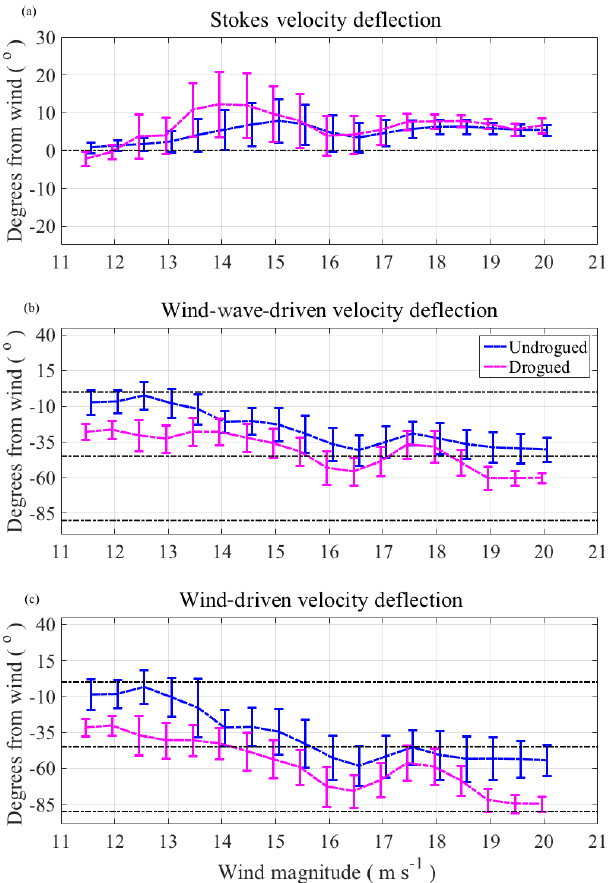
Figure 14. Average deflection angles at drifter locations during periods of high wind binned by UWIN-CM wind magnitudes on 0.5ms − 1 intervals. Horizontal dotted lines denote 0, 45 and 90 ◦ to the right of the wind. (a) UWIN-CM Stokes drift velocity di- rection at the surface (0m) and at 0.4m depth. (b) Velocity direc- tion of drogued and undrogued drifters after the subtraction of the pre-existing circulation estimate. (c) Velocity direction of the purely wind-driven component of the drifter velocities. All error bars show + / − 1 standard deviation within each bin. Data in wind bins lower than 11.5ms − 1 were omitted due to lack of data points and large standard deviations.